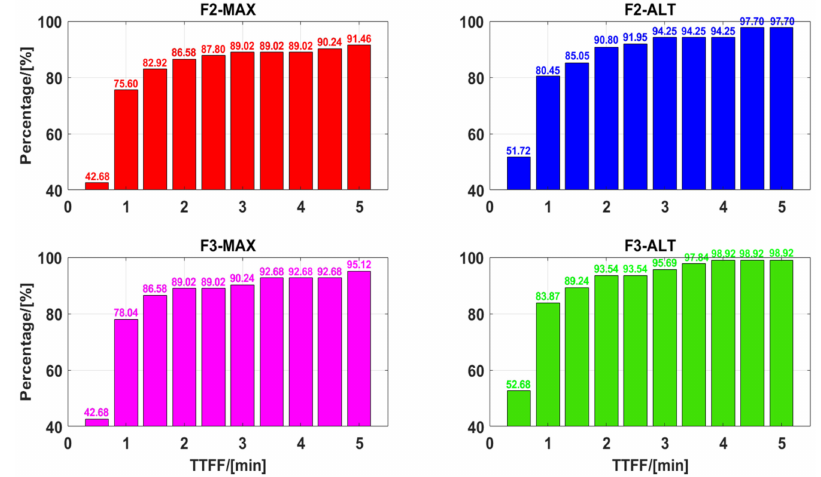
Figure 7. Cumulative distribution of TTFF of UCPPP